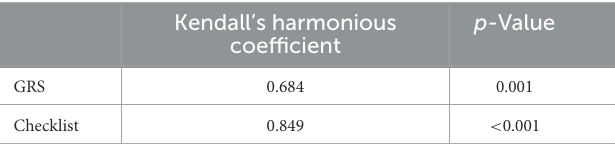
TABLE 6 Reliability results of the two tools used by the four